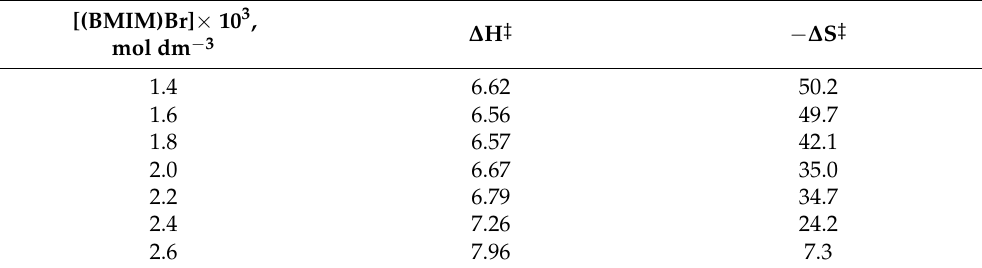
Activation parameters for the reduction of cis-[Co(ip) 2 (C 12 H 25 NH 2 ) 2 ](ClO 4 ) 3 , µ = 1.0 moldm − 3 in [BMIM]Br medium.